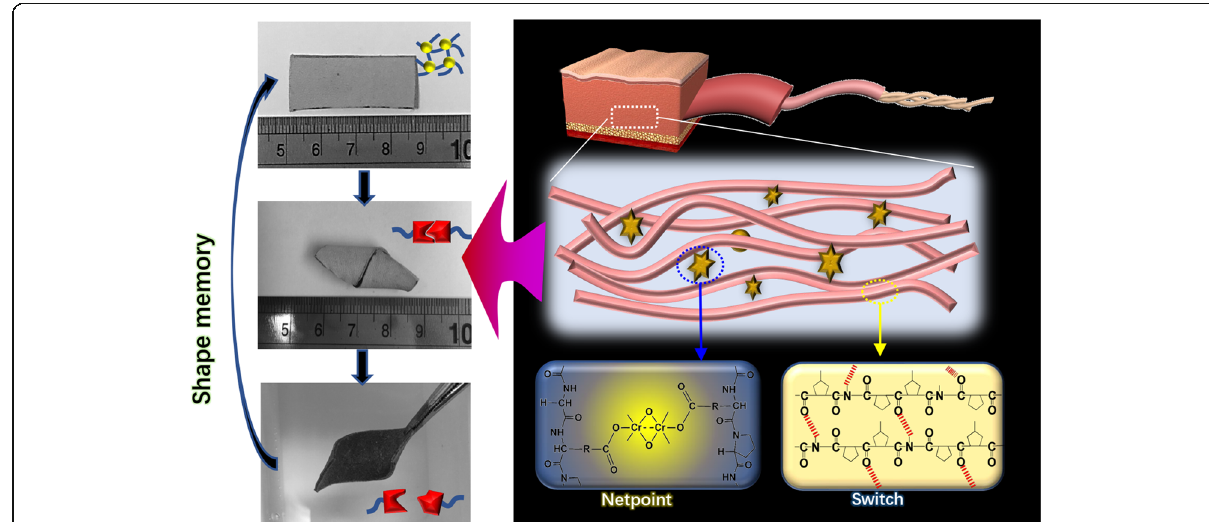
Fig. 7 Schematic of chromium (III) complexed skin collagen matrix with coalesced breathability, mechanical and shape memory properties